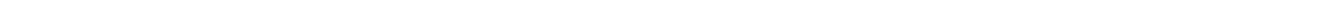
Fig. 3 Upregulated HEPH with high ferroxidase activity accumulates on the cellular membrane and leads to decreased LIP. a Immuno fl uorescence staining analysis of HEPH proteins in breast cancer cells transfected with G9a shRNA or treated with 5 µ M UNC0638 for 24 h. Shown are representative sections. Scale bars , 10 μ m. b Western blotting tested HEPH level in separated cell components of membrane and cytoplasm. c HEPH activity in G9a knockdown cells was measured by the oxidation of pPD and ferrozine assays. The homologue ceruloplasmin served as a positive control. d The cellular labile iron pool in G9a knockdown or inhibited cells was measured using the calcein-AM assay. The arrows indicate when the iron chelator was added. e The cellular labile iron pool in G9a-overexpressed cells was measured. f Western blotting tested HEPH overexpression in MCF-7 and MDA-MB-231 cells and the cellular labile iron pool in these cells were measured. All the results are presented as means ± SD from three independent experiments. Two-tailed unpaired Student ’ s T -test was performed. * P < 0.05, ** P < 0.01 and *** P <